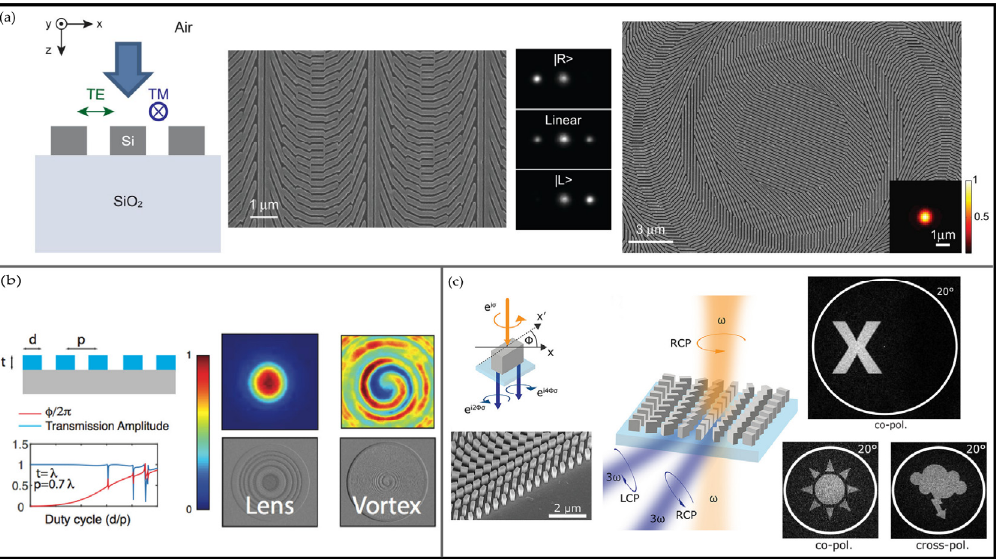
Figure 2. ( a ) Si geometric phase-type metasurface realizes the functions of axicons, lenses. Reprinted from [7] . Copyright 2014, The American Association for the Advancement of Science; ( b ) The SiN-based geometric phase metasurface realizes the functions of lenses and vortex beam generator. Reproduced with permission [42]. Copyright 2016, American Chemical Society; ( c ) Si geometric-phase metasurface achieves the nonlinear wavefront control for the third-harmonic generation (THG) and holograms. Reprinted from [58]. Copyright 2019 American Chemical Society.